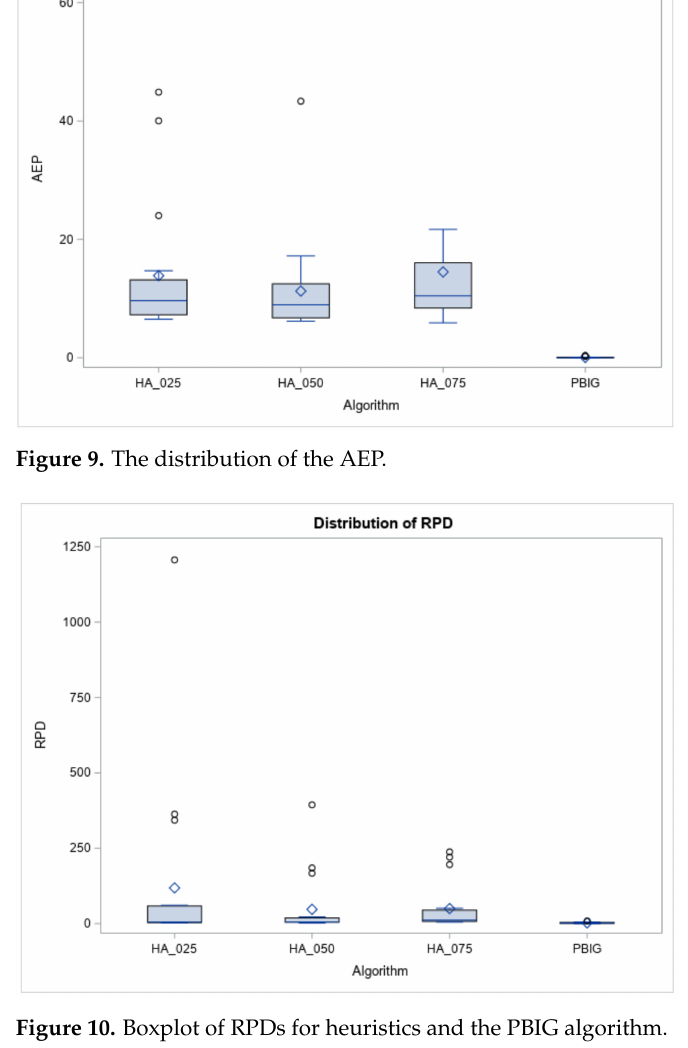
Figure 10. Boxplot of RPDs for heuristics and the PBIG algorithm.